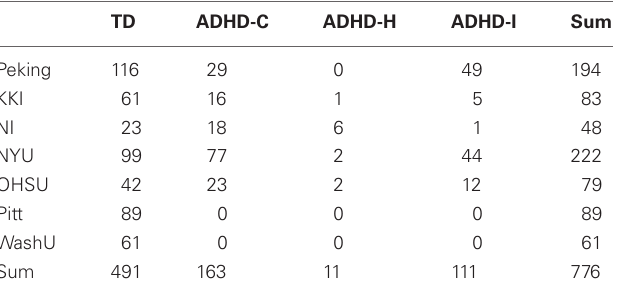
Table 1 | Number of subjects in training set data, by site and